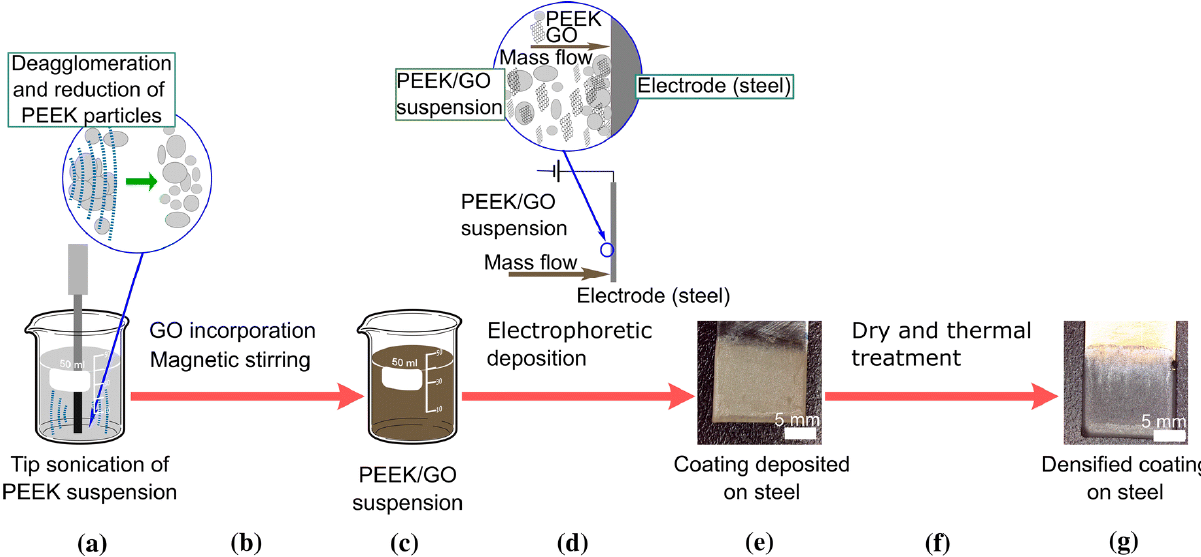
Figure 21. Scheme of the process followed for preparation of co-deposited PEEK/GO coatings. PEEK Suspension is sonicated using a tip sonicator ( a ) and after GO addition suspension is again stirred magnetically to form a stable suspension of PEEK/GO ( b , c ). Next, the suspension is set for EPD on 5mm steel substrate and a coating is obtained ( d , e ). A dense coating of PEEK/GO is obtained after dry and thermal treatment ( f , g ). Reproduced from [103] with the permission from Springer™.